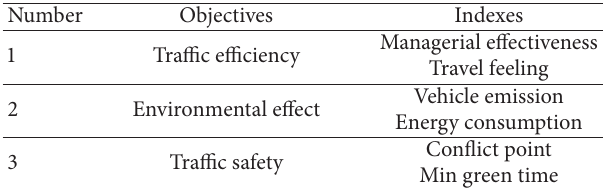
Table 2: Objectives of intersection